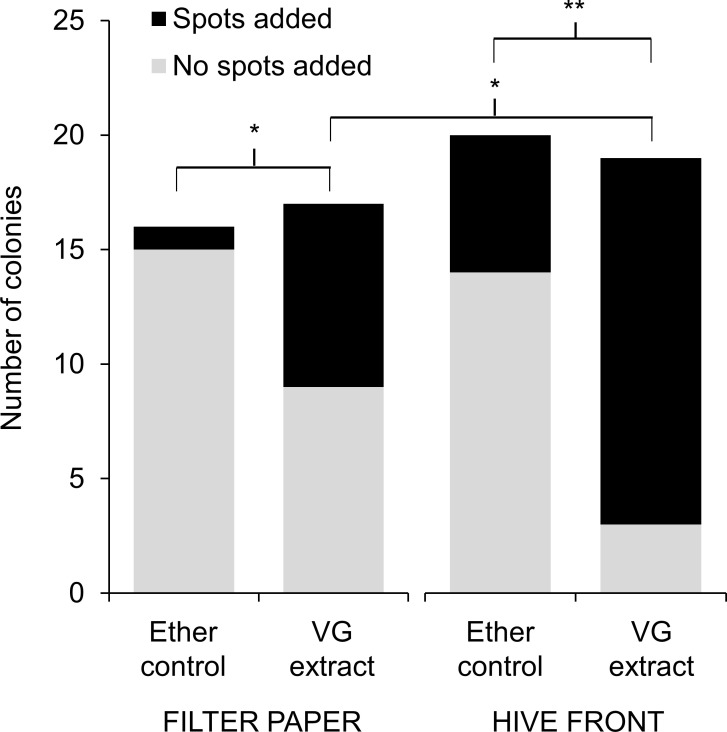
Exposure to VG extracts from Vespa soror workers induced spotting of hive fronts by most colonies.The addition of new spots to filter papers and hive fronts was determined six hours after colonies were exposed to filter paper soaked either in VG extract or in ether only (a sham control); refer to Fig 4 for details about the creation and presentation of VG extract-soaked and control filter papers. Asterisks indicate a significant difference between comparison groups, which are identified by brackets (* p ≤ 0.03; ** p = 0.001).